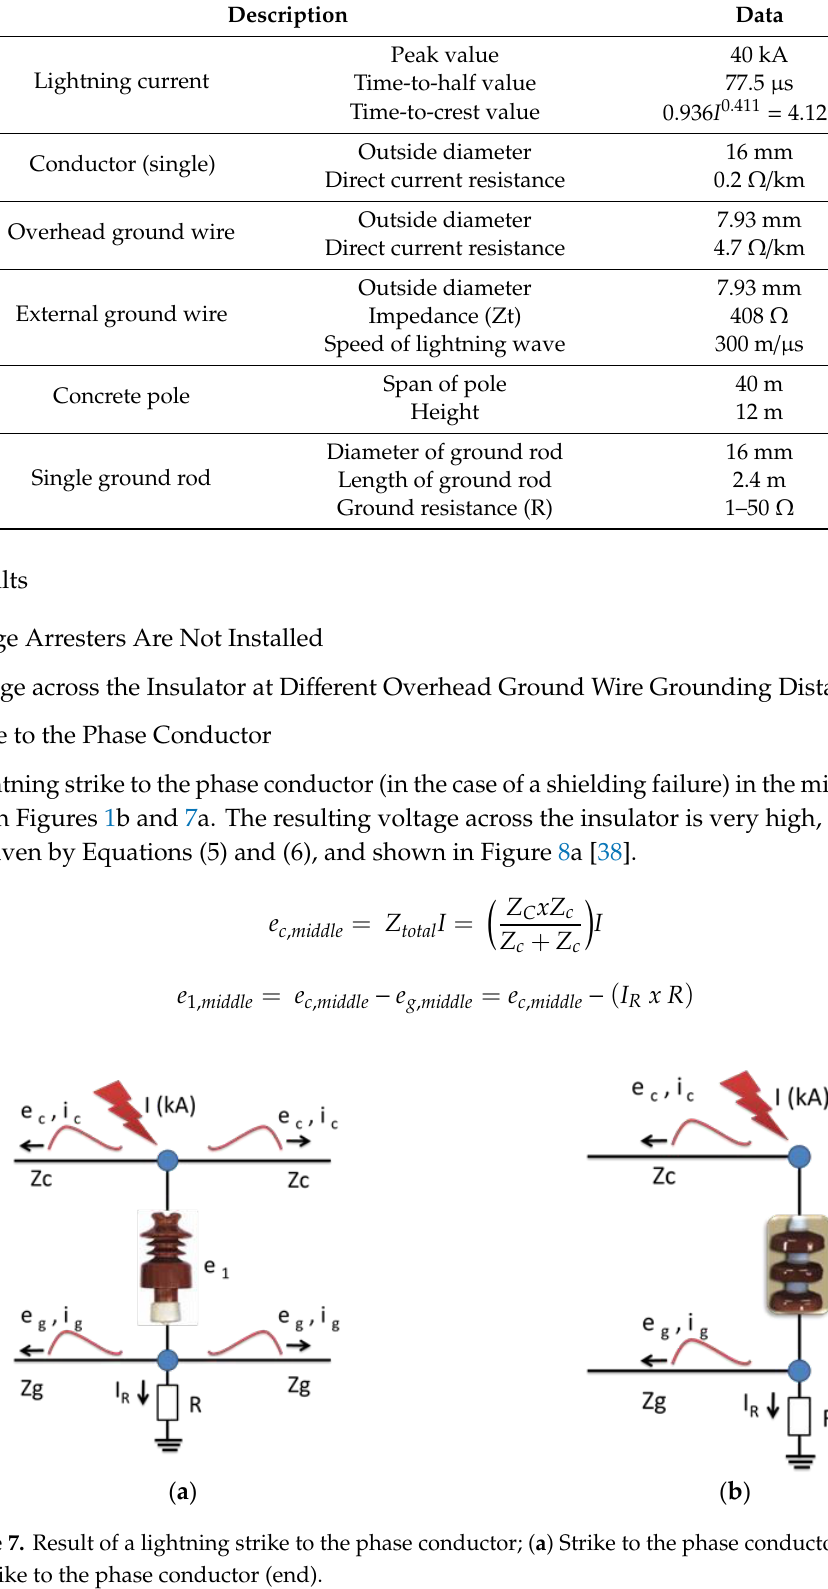
( a ) ( b ) Figure 8. Voltage across the insulator following a lightning strike to the phase conductor (lightning current wave shape = 4.12/77.5 μs, lightning current = 40 kA); ( a ) Strike to the middle of the phase conductor; ( b ) Strike to the end of the phase conductor.